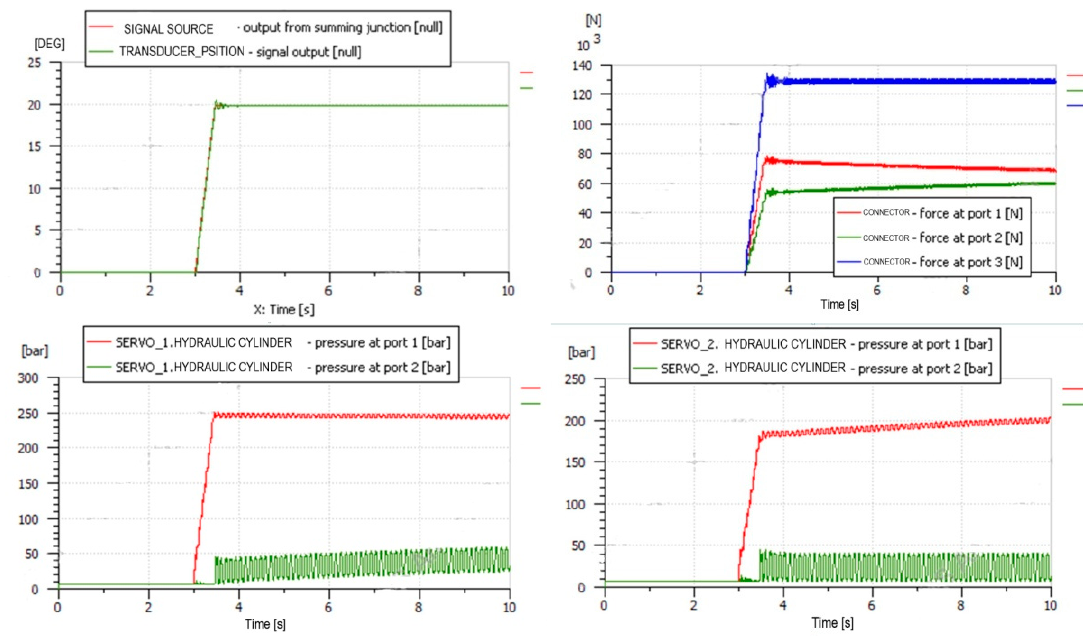
Figure 3. System behavior with ua ramp signal with a speed of 45°/s.